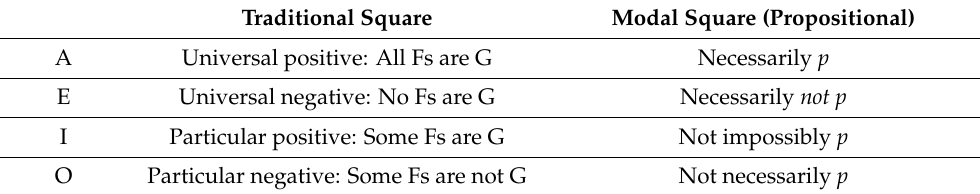
Figure 7. Blanché’s Hexagon, showing subalternation and contradiction among propositions lo- cated at vertices A, E, I, O, Y, and U.